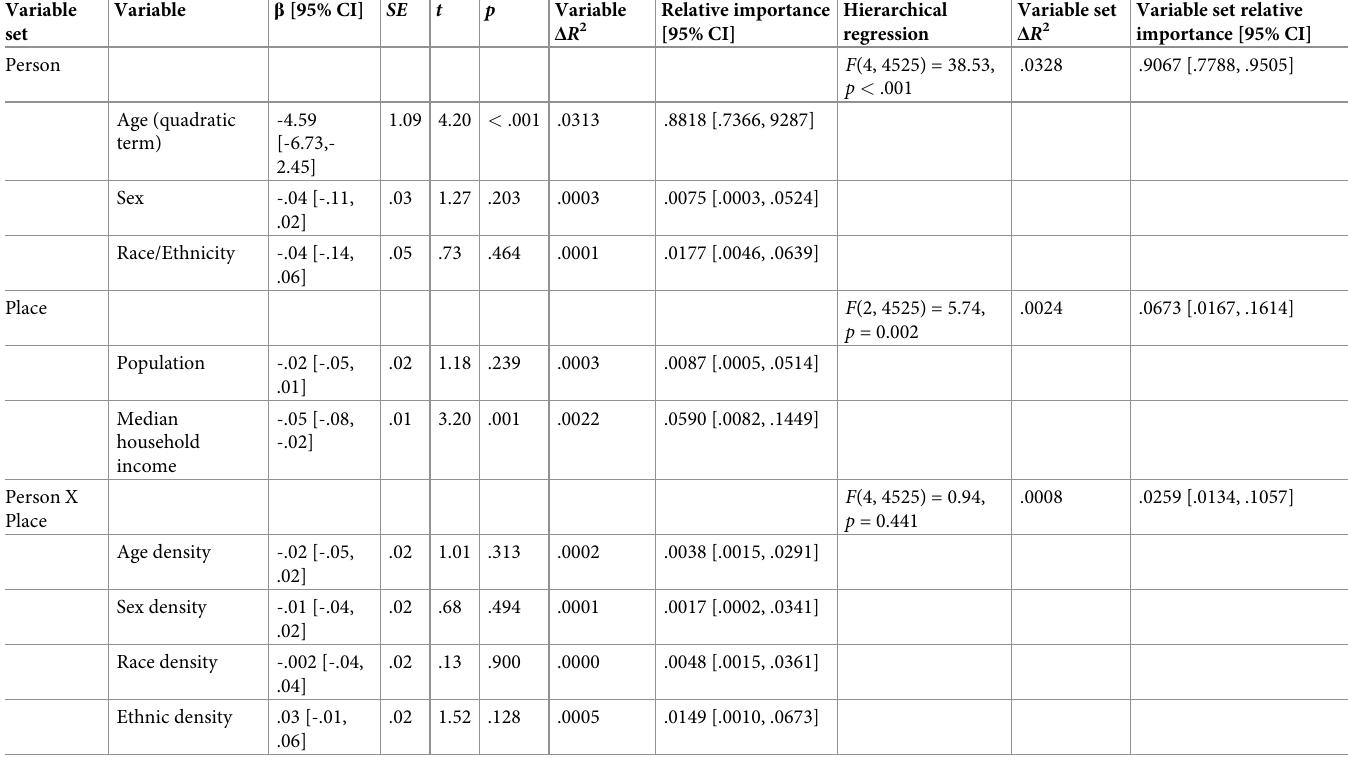
Table 3. Hierarchical linear regression results (N = 4,536).